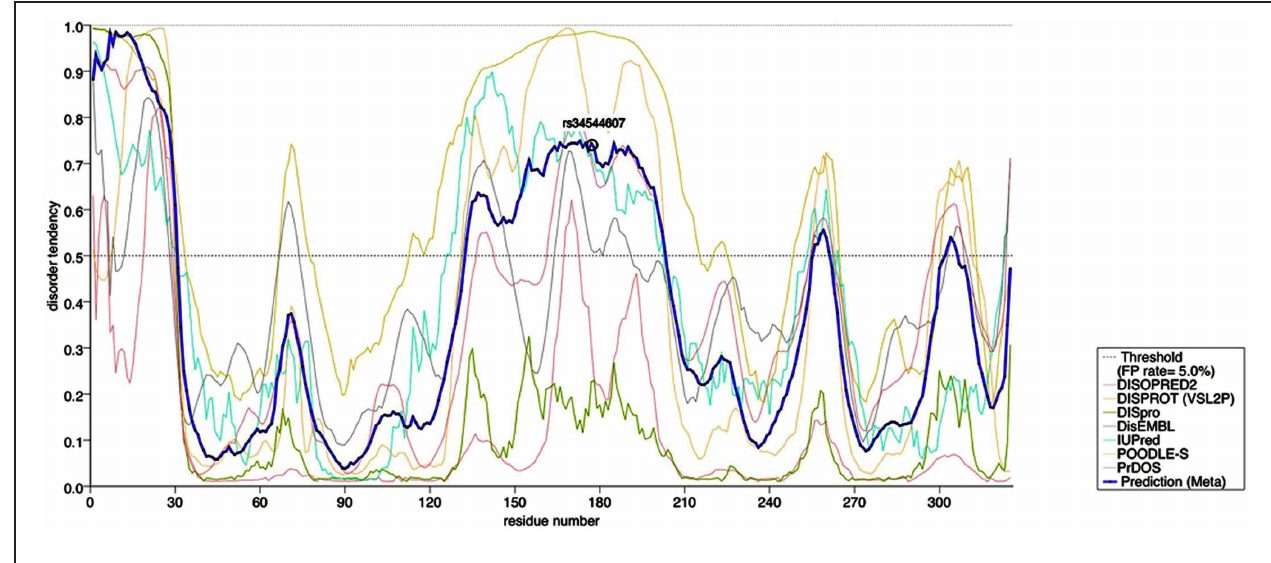
FIGURE 4 | Insilico structuralanalysis oftheKCTD12 protein. KCTD12 residues areplotted onthe x -axis.Eightprediction scores onthe y -axis (see legend) arecombinedusingmetaPrDOStolocatedisordered regionsbased